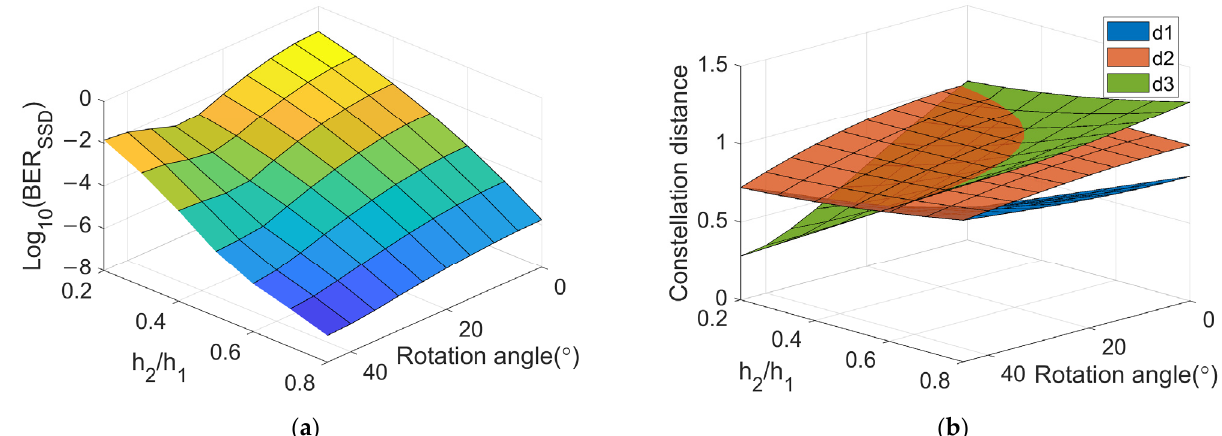
Figure 5. Results of the 1st channel gain setting. ( a ) BER. ( b ) Constellation distance.